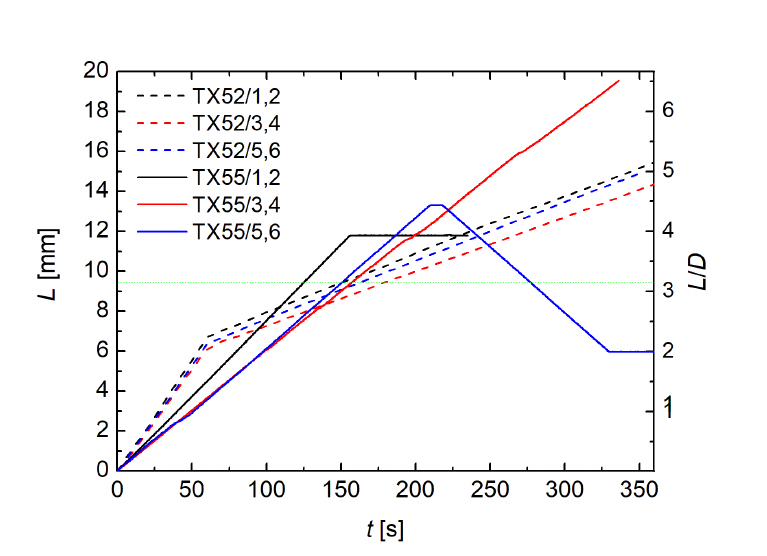
Figure 3. The drawing protocols for the columns in the six experiment pairs. The time counted from the start of the hull motion, which was initiated after entry into the microgravity phase. The dis- tance L was measured from the fixed top to the upper rim of the hull that enclosed the fluid cylinders. The horizontal green line indicates the critical aspect ratio α c